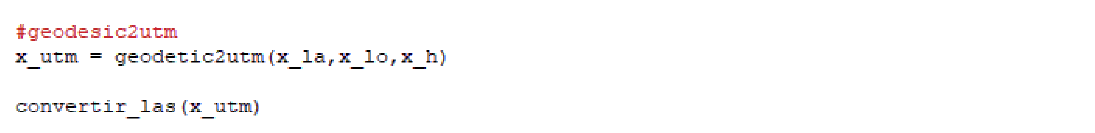
Figure 14. Conversion of vectors to the UTM reference system.